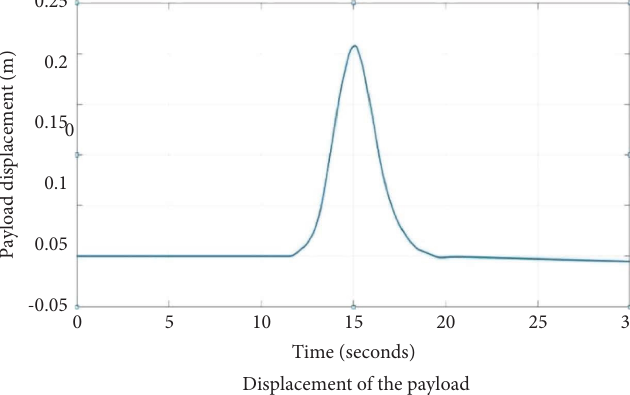
Figure 8: System response with the second input signal using hybrid